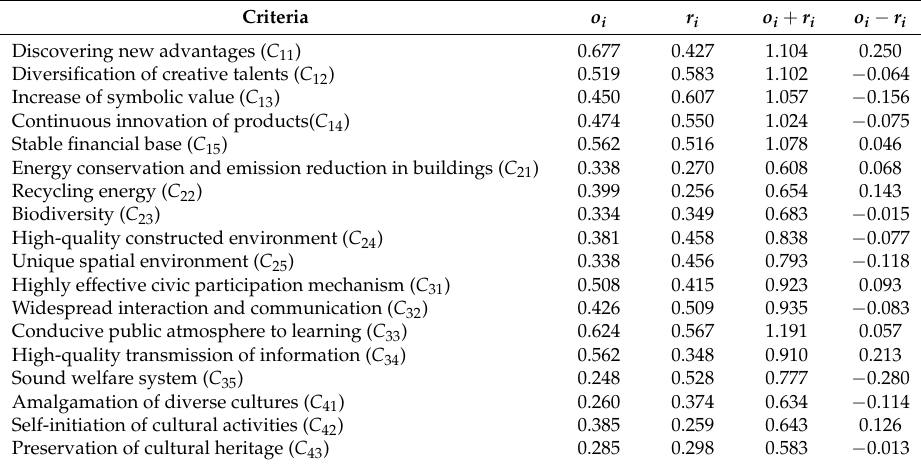
Table A4. Sum of influences given/received on criteria.